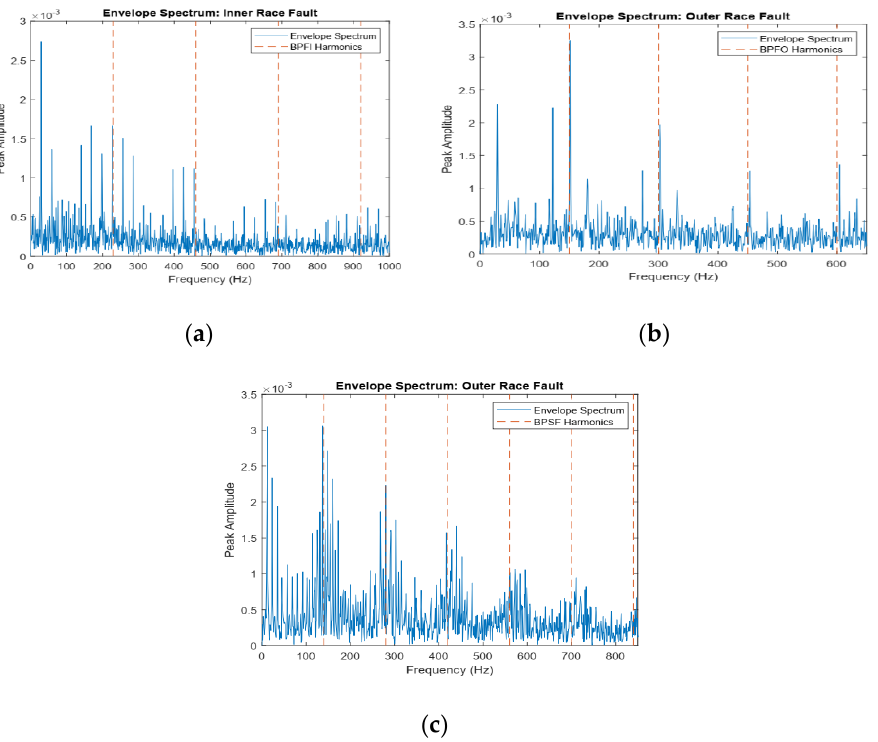
Figure 8. Envelope spectrum for the ( a ) inner fault, ( b ) outer fault, and ( c ) roller